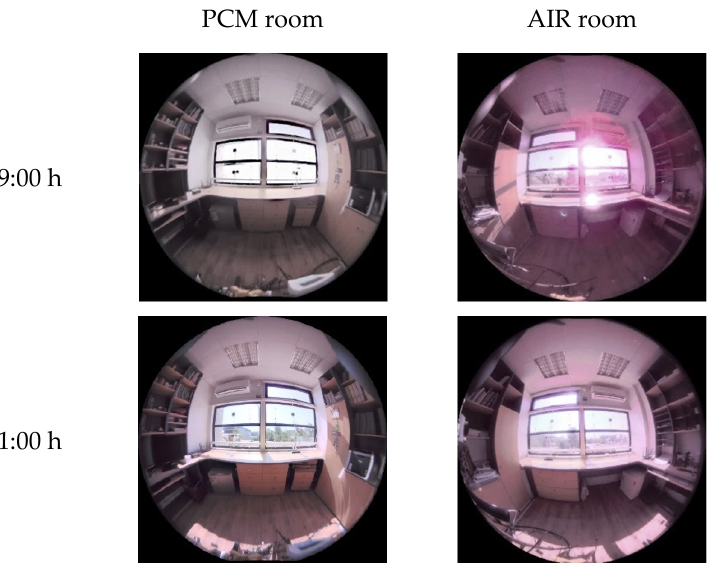
Figure 4. Pictures of the experimental setup of both offices and PCM in solid-state and liquid state. 20 February 2020, at local time (UTC-3).